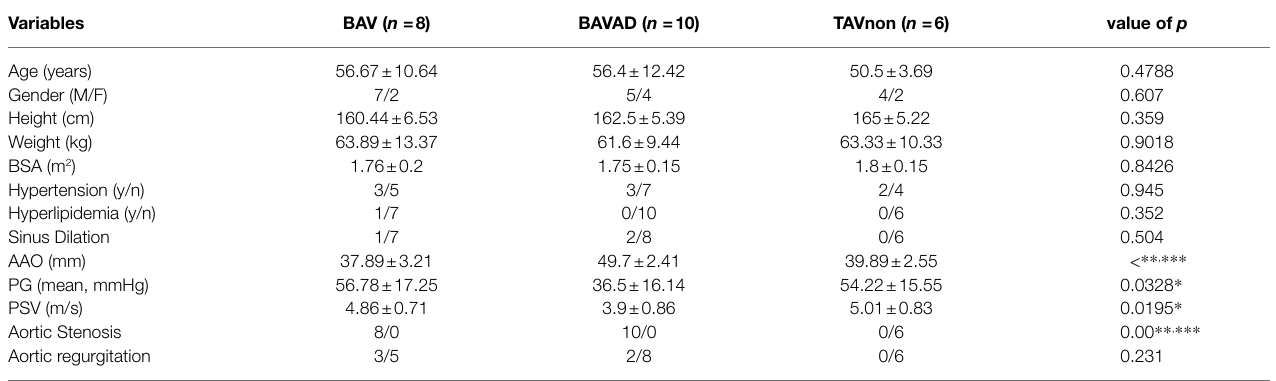
TABLE 1 | Baseline characteristics. Variables